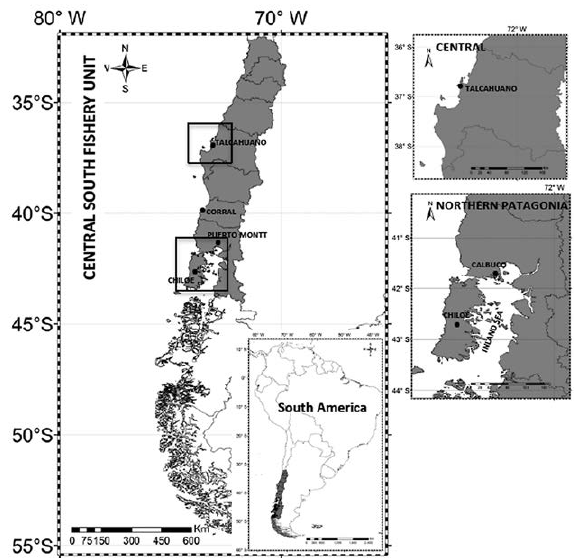
Fig. 1. – Engraulis ringens fishing zones (central and northern Pa- tagonia) where the samples were obtained.